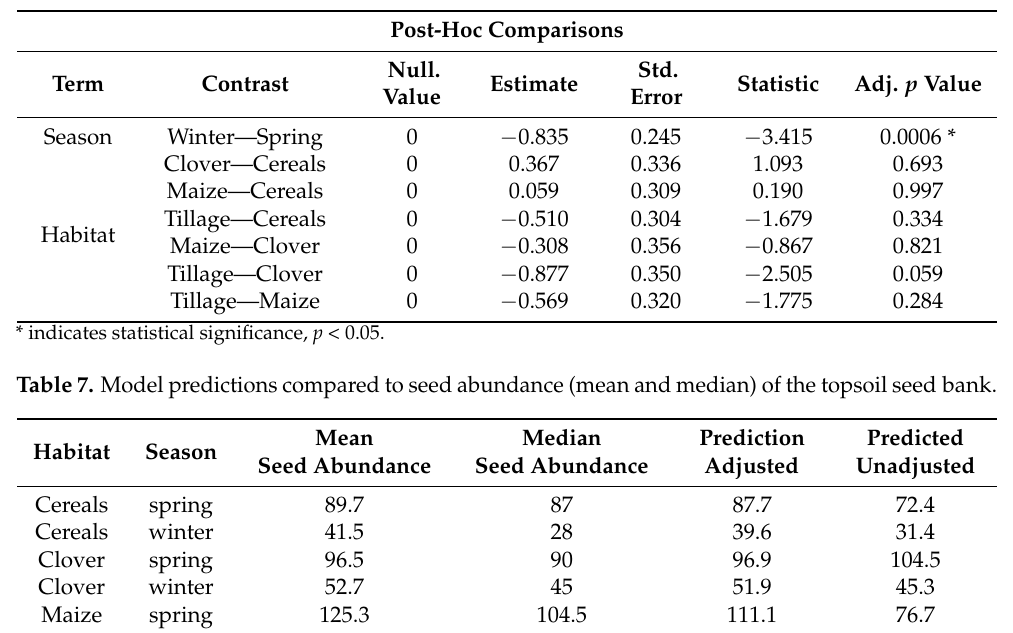
Table 6. Tukey all-pairs comparisons for seed abundance of the topsoil seed bank.